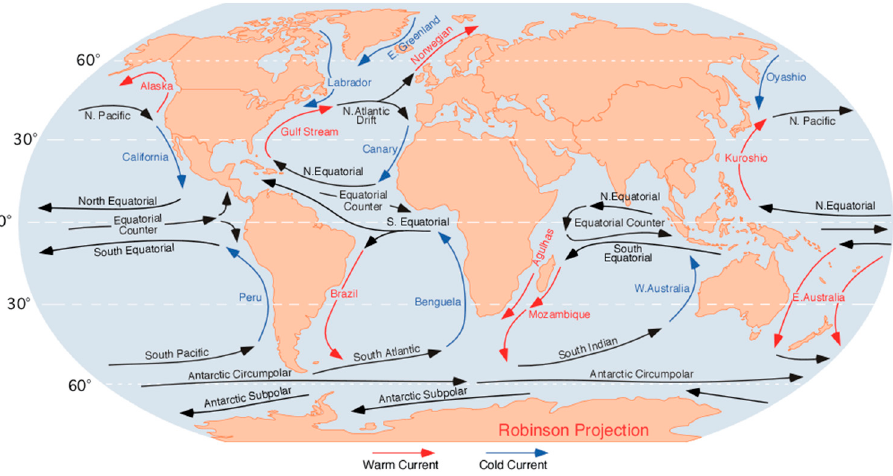
Figure 7. Main global current [23].